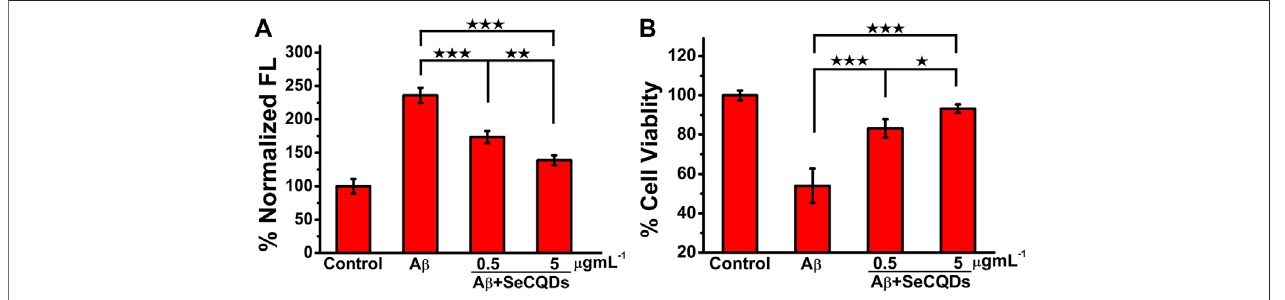
FIGURE 6 | Effect of the SeCQDs on intracellular ROS formation in A β 40-treated PC12 cells (A) . Protection effects of SeCQDs on A β 40-induced cytotoxicity of PC12 cells (B) . The concentration of A β 40 was 10 μ M. The control group was A β 40 untreated cells. Data represents mean ± SEM. * p < 0.05, ** p < 0.01, *** p < 0.001.